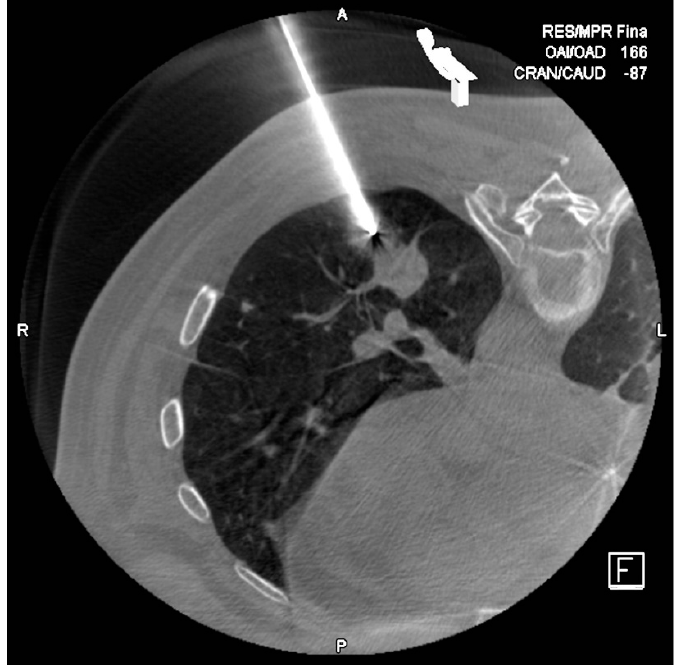
Figure 4. Lug nodule in lower left lobule of a 63 year old man. In the first control CT, we objectified the 17G needle perfectly positioned next to the target node.